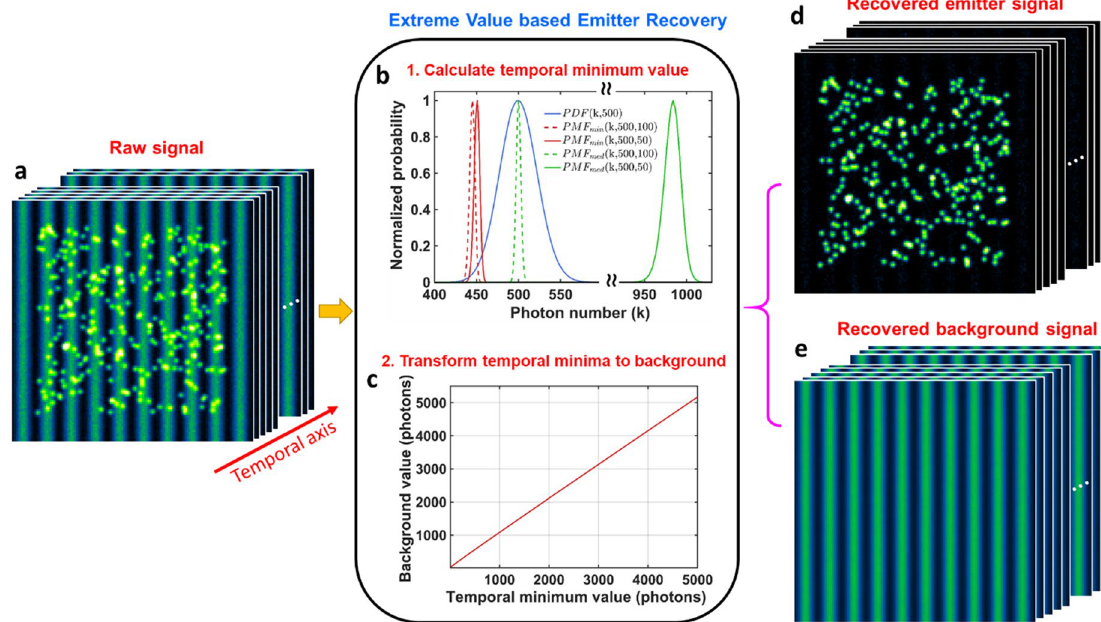
Figure 1. ( a ) An image sequence (stack) of raw images composed of emitters mixed with heterogeneous background. ( b–c ) The workflow of extreme value based emitter recovery (EVER), including ( b ) the calculation of temporal minimum value from each pixel and ( c ) transformation of temporal minimum value to the actual background value based on our derived look-up table. ( d ) The recovered emitters and ( e ) background images. Note that, the blue line in ( b ) shows the probability density function ( PDF ) for a Poisson distribution with an expected background value of 500 photons. When probabilities of the occurrence of the emitter’s signal (500 photons) are 50%, the mean of the probability distribution of temporal minimum value ( PMF min ) (red solid lines) only increase by ~ 2% (~ 8 photons) from the case without emitters (red dashed line). While the temporal median value ( PMF med ) increases by ~ 96% (~ 480 photons) for the same scenarios (green solid and dashed